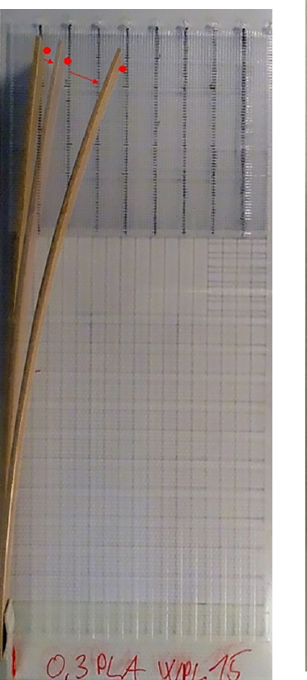
Figure 8. Use of wood–PLA filament in 4D printing—bimaterial actuator principle—elements with layers of PLA and layers of wood–PLA changing shape when exposed to changing climate conditions ( left ) [76]; principle of 4D printing ( right ).